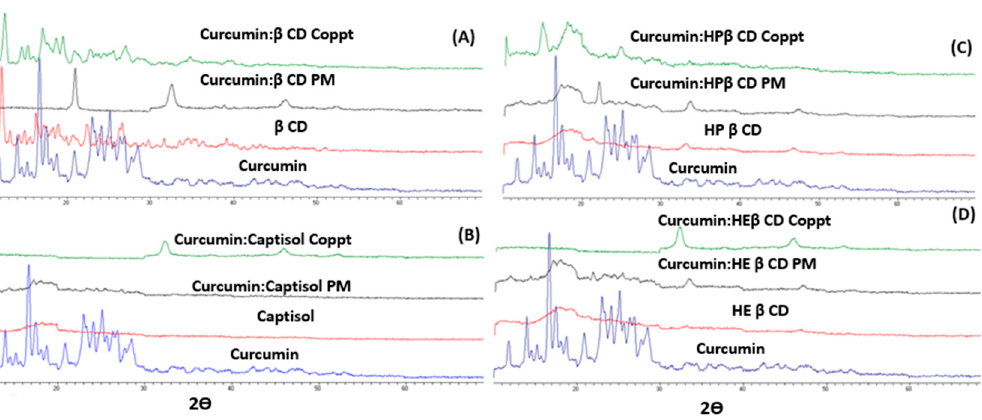
Figure 5. A–D. XRD spectra of curcumin, curcumin: cyclodextrin complexes β -cyclodextrin ( A ), Captisol ( B ), hydroxypropyl β -cyclodextrin ( C ), and hydroxyethyl β -cyclodextrin ( D ) prepared